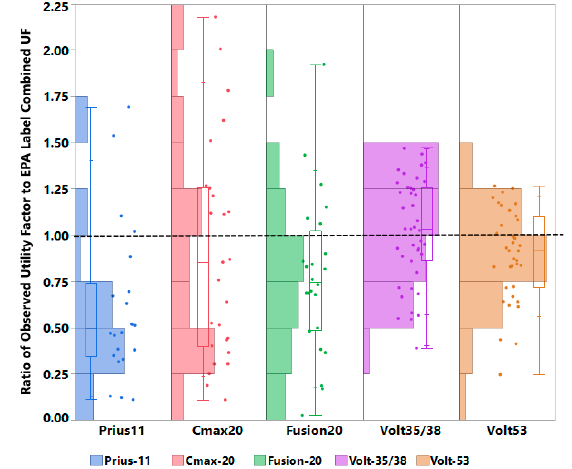
Figure 2. Ratio of observed Utility Factor (UF) to EPA label city / highway combined UF by PHEV model. Values above one indicates observed UF of PHEVs exceeded EPA estimates.